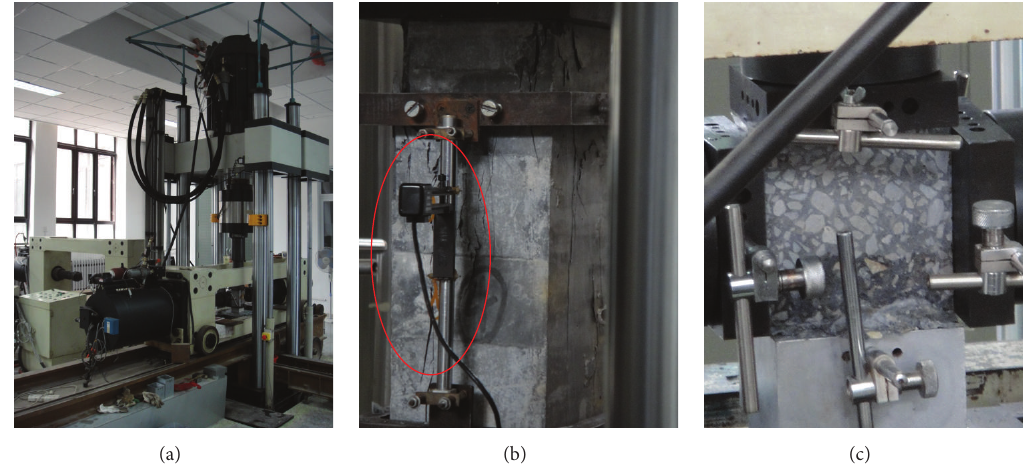
Figure 9: Multiaxial compressive loading